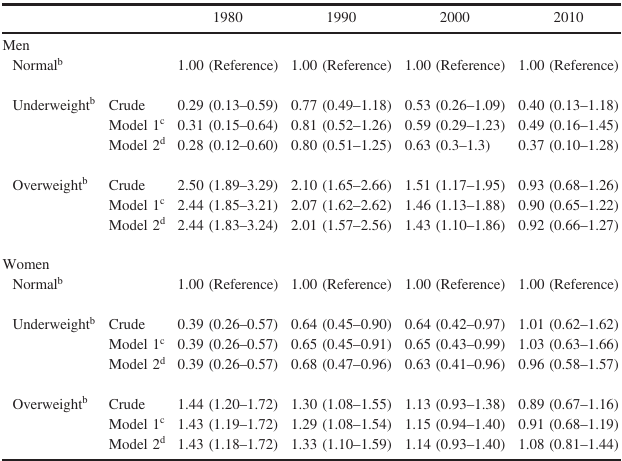
TC, total cholesterol. a High TC was de fi ned as ≥ 220mg = dL. b BMI was categorized into underweight (<18.5kg = m 2 ), normal (18.5 – 25.0kg = m 2 ), overweight ( ≥ 25.0kg = m 2 ).